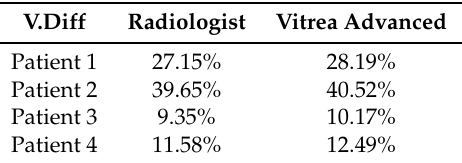
Table 3. Volume difference percentage obtained by classical method used by radiologist and Vitrea Advanced